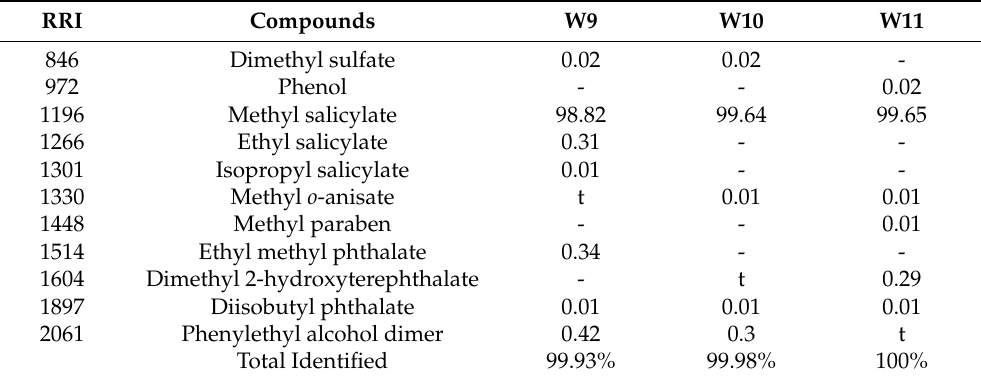
Table 6. Comparison of volatile compounds present in commercial methyl salicylate with methyl salicylate synthesized from aspirin and synthesized from salicylic acid a ; “-” indicates not detected and “t” indicates trace